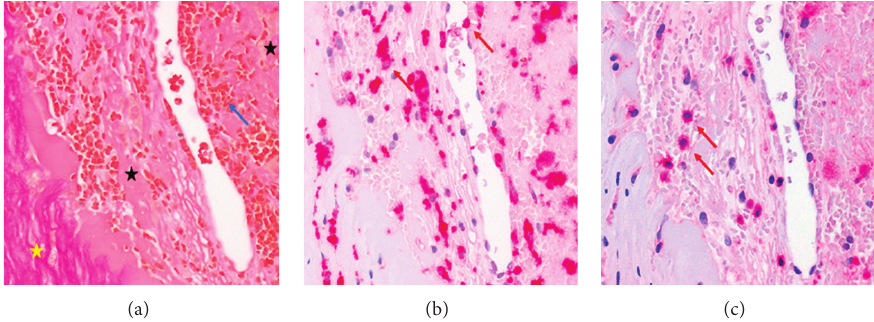
F 4: (a) Elastica van Gieson staining corresponding to yellow-boxed area in Figure 3(a). e blue arrow indicates area of acute intraplaque hemorrhage close to area of neoangiogenesis. Note that individual erythrocytes are clearly discernible. Black stars indicate thrombotic material. e yellow star indicates surrounding solid �brotic tissue. (b) Immunohistochemistry of the same region as shown in Figure 3(a) with dense in�ltrate of CD68-positive macrophages indicated by red arrows. (c) Immunohistochemistry of same region as shown in Figure 3(a) with in�ltrate of CD3-positive T cells indicated by red